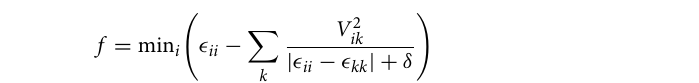
The metric f can be used to determine the relevant cluster of a k-clustering without having to compute k diagonalizations. Although we currently have a partial understanding of why there is no clear decreasing mono- tonicity between k and the accuracy of the selected cluster; the explanation of the differences in accuracy between clusters are fully contained in the factors of this gauge metric f . This metric is derived and analyzed further in the Supplementary Information. Looking at the pair-wise differences in the metric f values of the best clusters across multiple k-clusterings , we see that the lowest difference determines the cluster with the best accuracy for a given molecule. This relation- ship between the metric f differences and the energy differences is monotonic and linear as shown in Fig. 6c for H 2 O, N 2 , and BH 3 . The most accurate cluster for H 2 O was discovered from the 2-clustering with a small energy difference of 0.05 kcal/mol. This remained the same for 3-clustering resulting in a metric f difference of 0.0. For N 2 , the smallest energy difference of 0.18 kcal/mol and a low metric f difference between the 4- and 5-cluster- ing confirm that the most accurate cluster comes from the 5-clustering . Similarly, for BH 3 , the smallest energy difference of 0.30 kcal/mol and lowest metric f difference between the 3- and 2-clustering indicate that the most accurate cluster is from the 3-clustering . These results are shown in the Supplementary Information. The most accurate cluster includes low energy SDs (the lower the better), which are close in energy, with high weights between the SDs (as nodes). The gauge thus provides a quick test if the inclusion of low energy SDs is sufficient